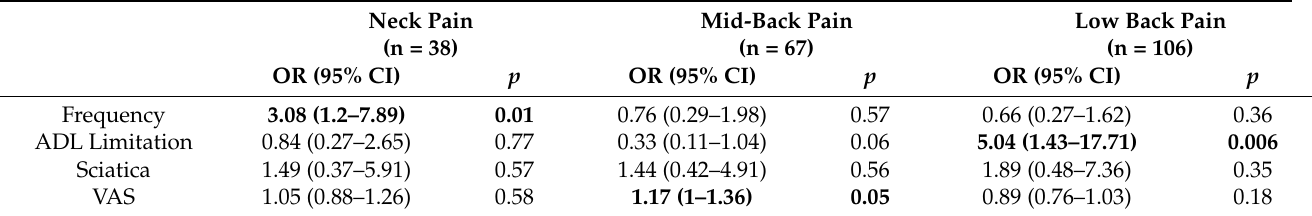
Table 4. Characteristics of back pain in the last year by spinal pain